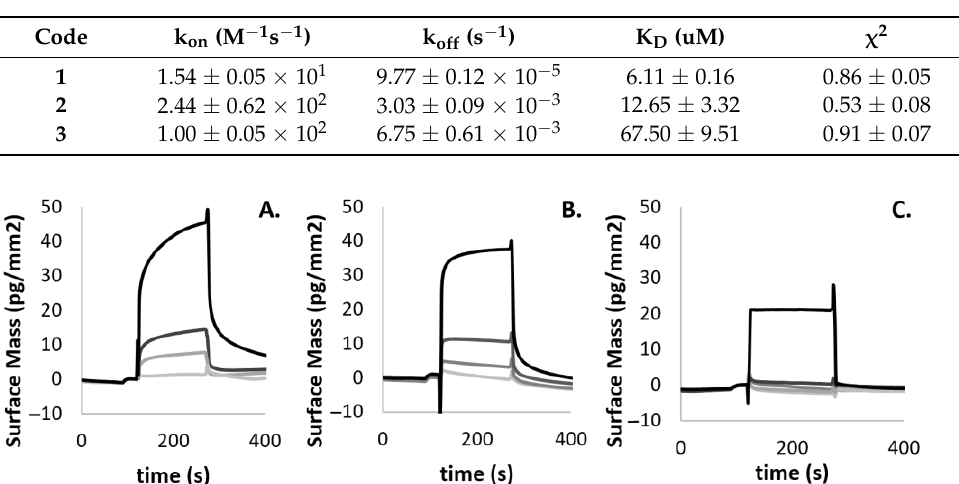
Figure 3. Quantitative binding kinetics of Mab -SaS vs. 1 ( A ), 2 ( B ), and 3 ( C ), measured by GCI. All curves were blank subtracted. Experiments were performed in triplicate. All the quality assessments (i.e., χ 2 shown in Table 1, parameter errors, and residual plots were acceptable; the sensorgrams had sufficient curvatures and the kinetic constant k off were within the measurable range) were fulfilled. Descriptive Statistical Analysis was employed to calculate the mean of the obtained values of k on , k off , and K D as a measure of central tendency; standard deviations of the former values were computed as a measure of